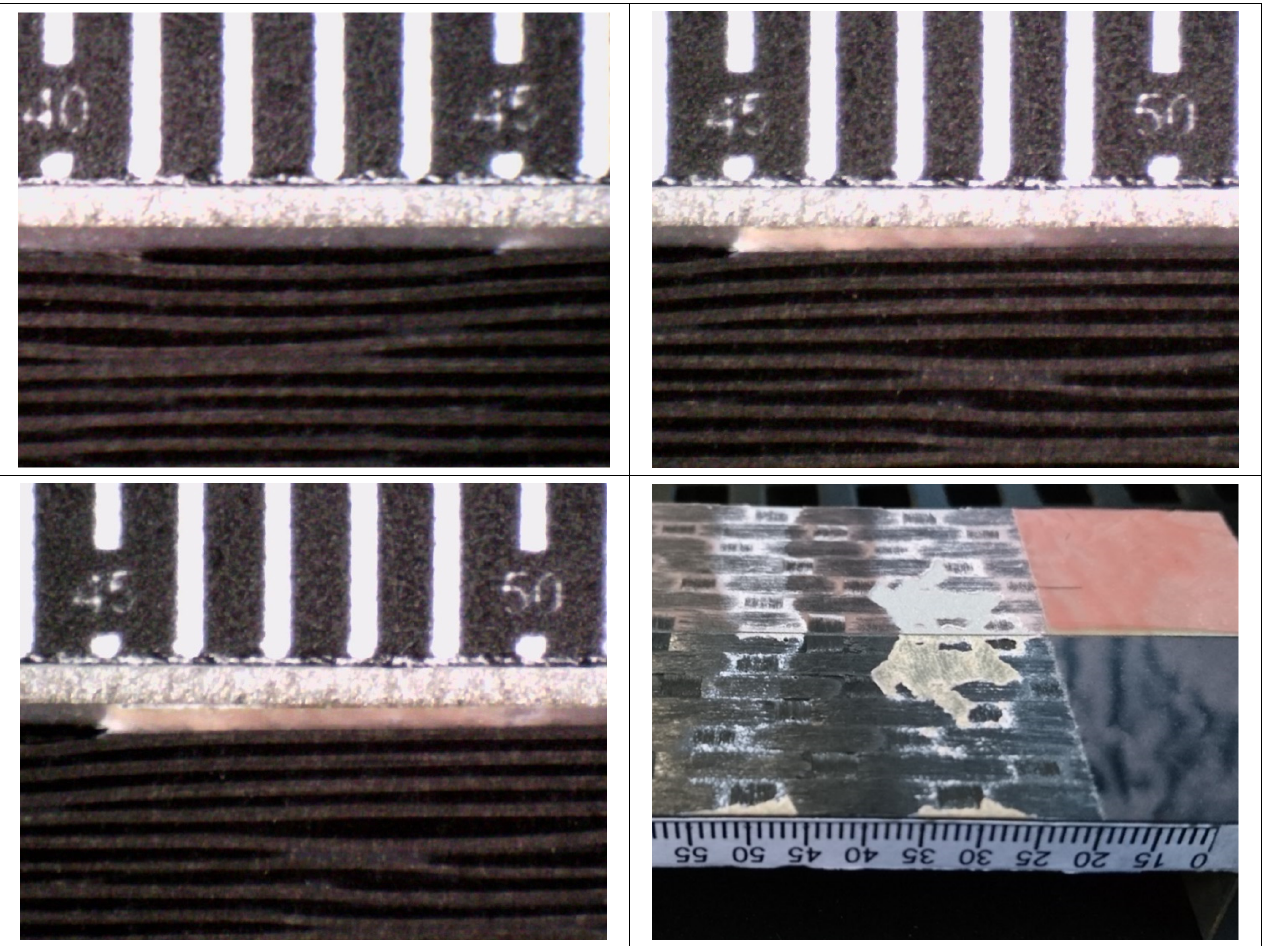
Figure 30. Sequence of crack propagation and relationship with the fracture surface of the DCB_CA_9323_01 joint.